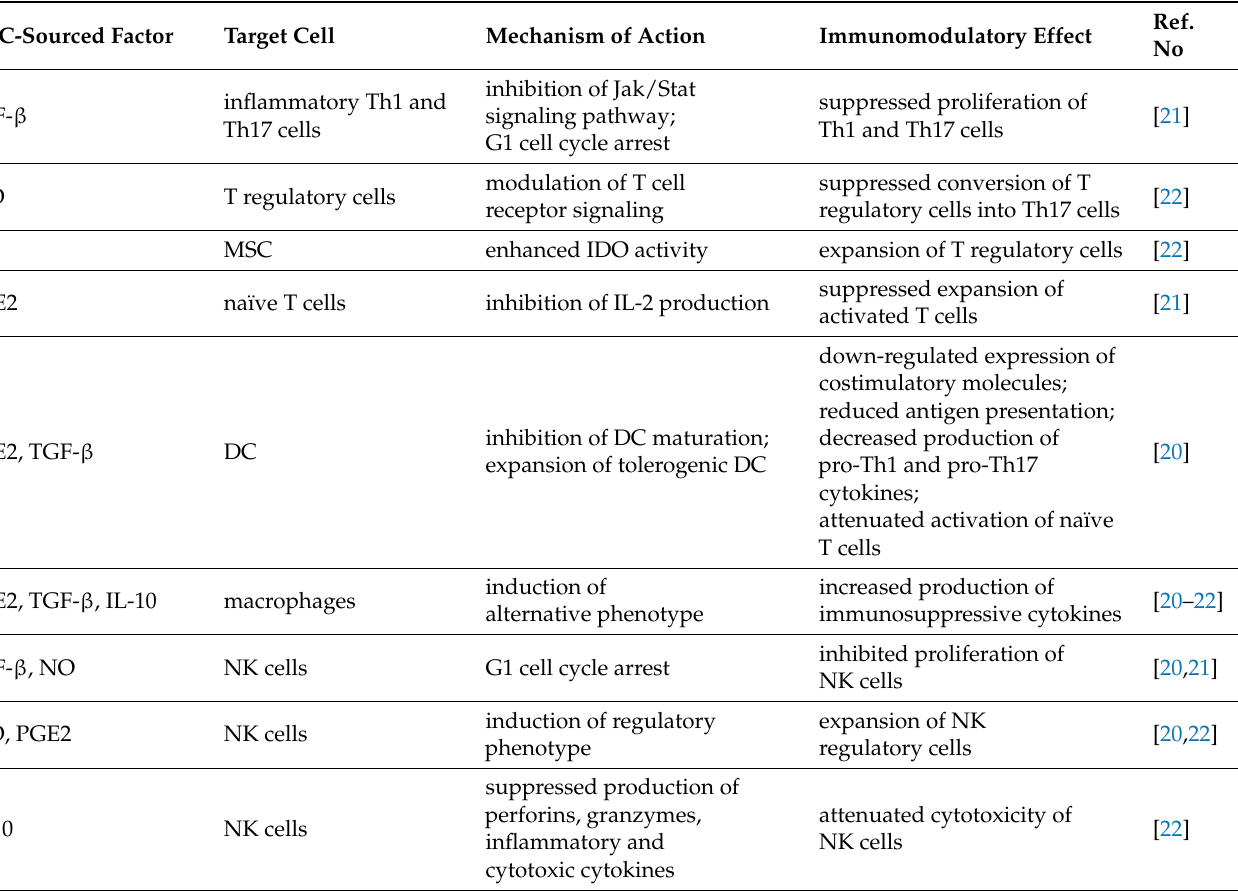
Table 2. Molecular mechanisms responsible for mesenchymal stem-cell-based immunoregulation in the treatment of